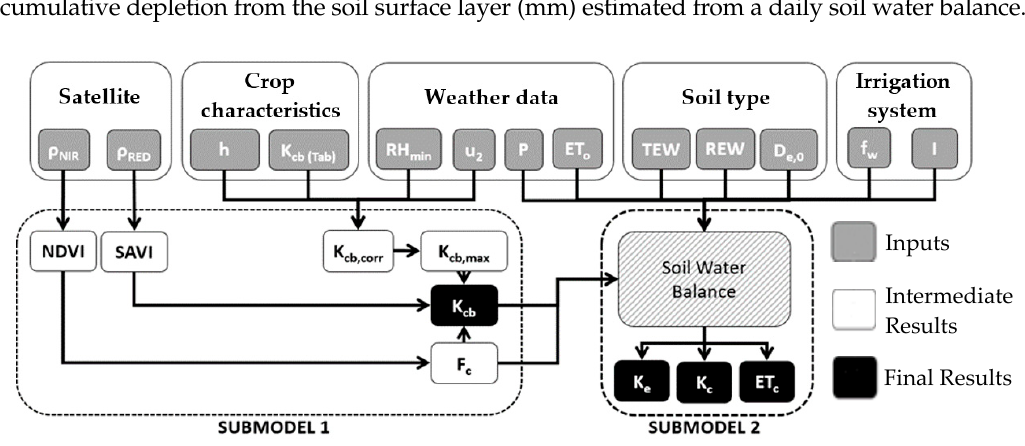
Figure 1. Flowchart of the dual K c model implemented into ArcPy, showing the inputs, intermediate results, and outputs. ρ NIR and ρ RED are the reflectances corresponding to the infrared and red bands, respectively; f w is the fraction of soil surface wetted by irrigation; and I is the irrigation depth on each day that infiltrates the soil (mm). For definitions of the rest of abbreviations used in the figure, readers are referred to the main text.